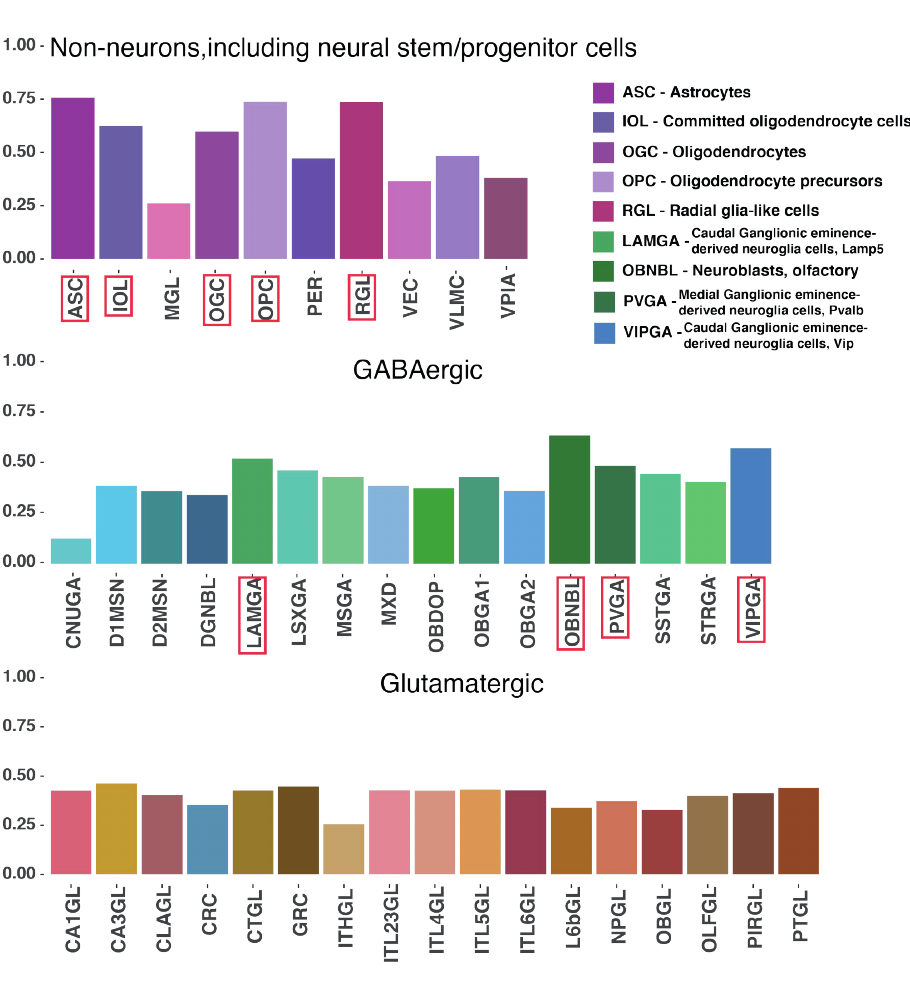
Figure 4. cCREs are highly represented within mouse enhancers involved in LRIs . Histograms represent the relative proportion of cCREs (Li et al., 2021) [11] overlapping our mouse